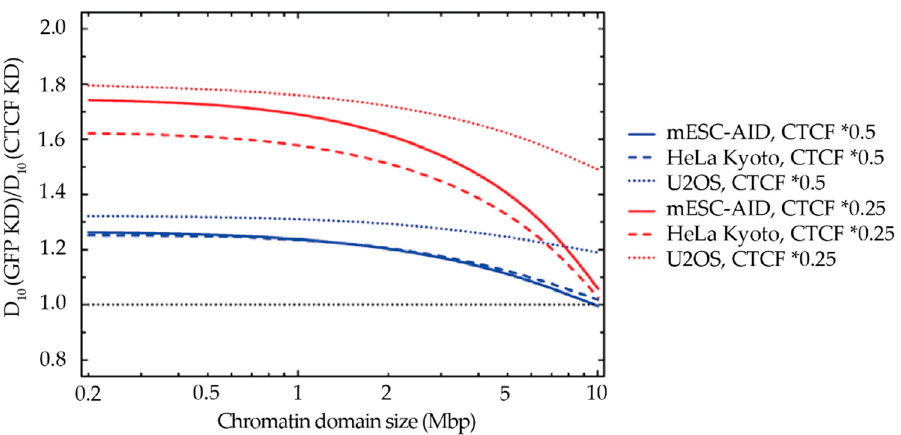
Figure 10. GLOBLE predictions of radiation sensitivity analyzing the impact of CTCF depletion on differentially sized control chromatin domains. As an indicator of the impact, the ratios of D10 (the dose required to achieve 10% survival) under control conditions to the D10 after CTCF depletion are used. CTCF depletion has the most significant impact for control domain sizes below approximately 2 Mbp for all 3 cell lines, whereas towards larger control domain sizes, the impact is reduced. The black dotted line indicates the reference value, corresponding to CTCF depletion having no impact.